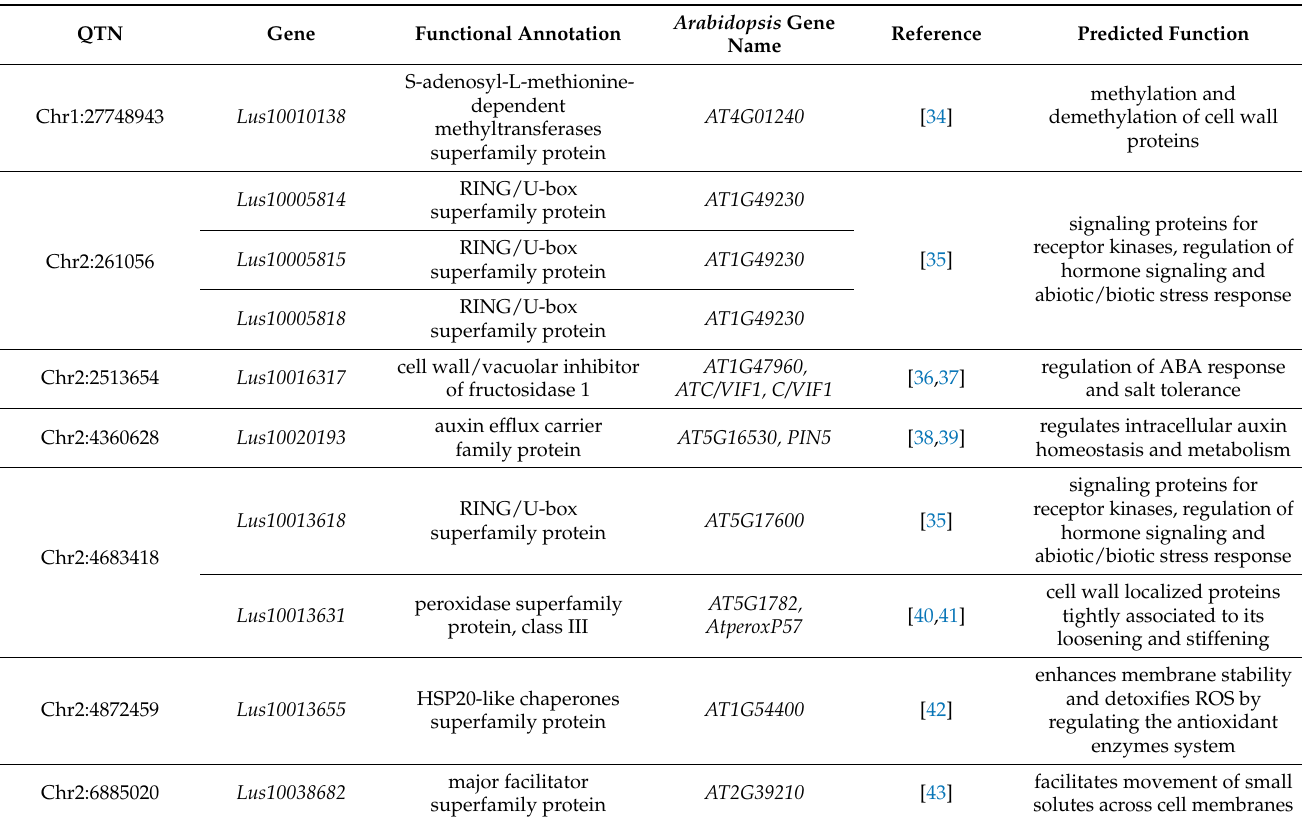
Figure 3. Venn diagram representing the number of differently expressed genes in QTN loci detected with GAPIT ( a ) and GEMMA ( b ). Table 1. Candidate genes predicted from the intersection of GAPIT3 R hits with data on gene expression in